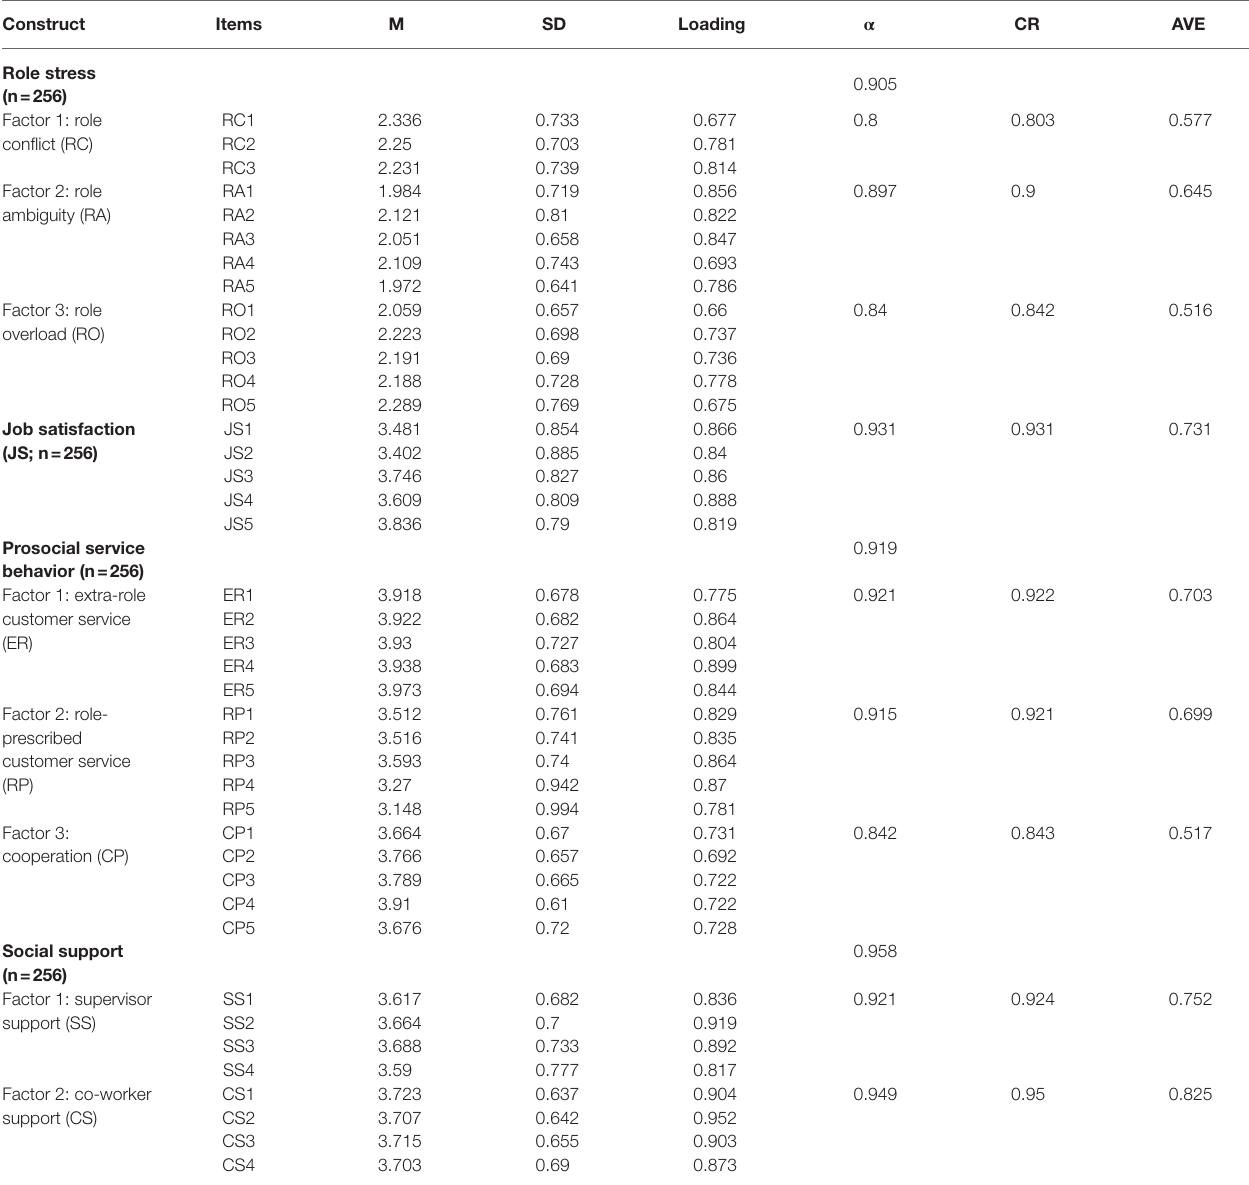
TABLE 2 | Result of measurement